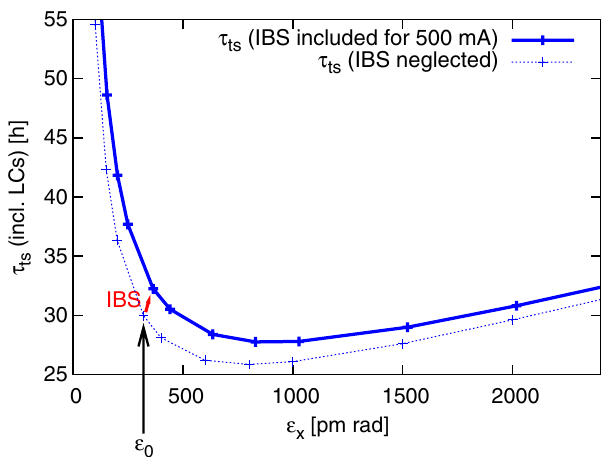
FIG. 4. Touschek lifetime (including the effect of LCs) from 6D tracking with T RACY -3 as a function of equilibrium emittance assuming the lattice emittance could be adjusted freely while keeping the energy spread constant. The overall MA has been set to 4.5% while the vertical emittance is adjusted to 8 pm rad. The effect of IBS at 500 mA stored current vs no IBS is displayed.